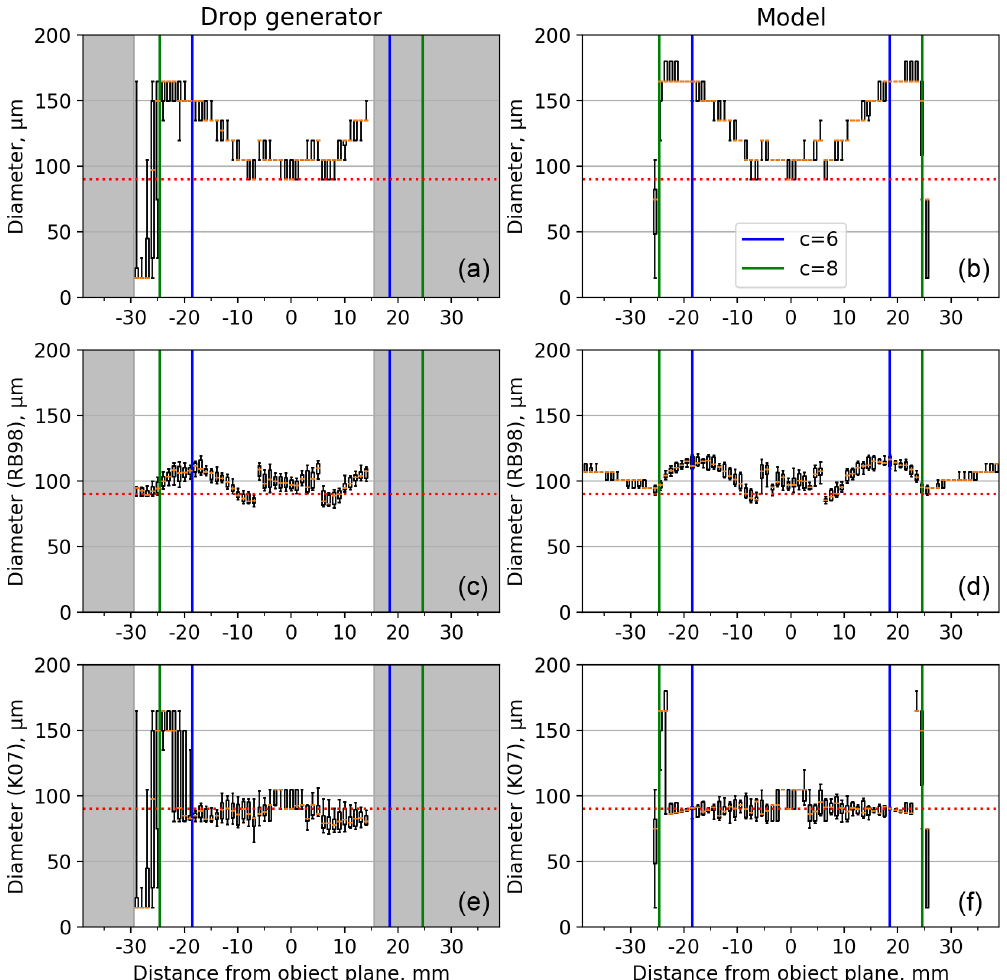
Figure 4. Same as Fig. 2 but panels (a) , (c) and (e) show results from the laboratory experiments using a 120µm printhead and panels (a) , (c) and (e) show the modelled image diameter from a 90µm